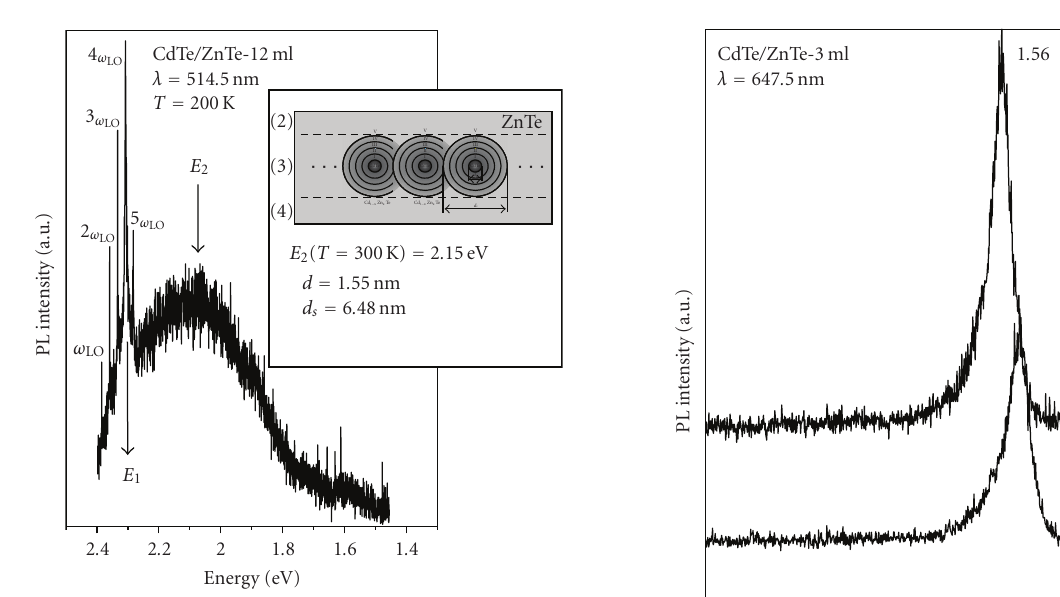
Figure 3: Typical PL spectra of sample with 12 ml of CdTe in the finishing layer; PL spectra are excited by λ = 514.5 nm Ar-laser line and recorded at 200 K. Insert: schematic presentation of the structure of SAQD.